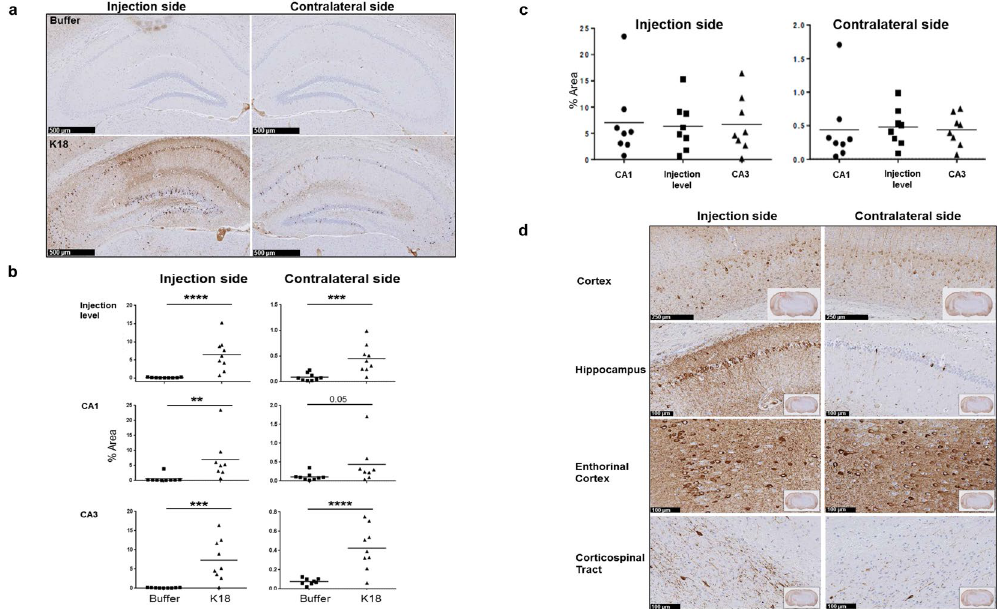
Figure 6. ( a ) AT8 immunoreactivity ipsilateral and contralateral at the level of HPC-CA1 and CA3 structures, scale bars: 500 µ m ( b) Quantification of AT8 labeling revealed strong increases of the tau pathology in different areas of the injection side as compared to the contralateral side, ( c ) total AT8 labeling in the hippocampus and ( d ) distribution of AT8 labeling in the cortex, hippocampus, enthorinal cortex and corticospinal tract. One way ANOVA, Bonferroni correction for multiple comparisons, significance levels p < 0.05, K18 (n = 9) vs buffer (n = 9). 2 animals across different conditions were discarded from the anlaysis because it was difficult to accurately quantify AT8 in some area. Scale bars: cortex: 250 µ m; hippocamps, enthorinal cortex and corticospinal tract: 100 µ